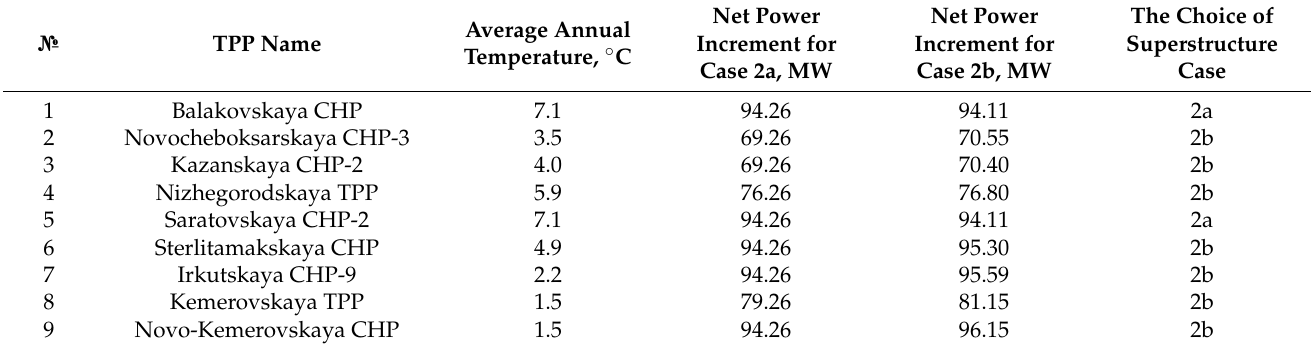
Table 8. The comparison of the energy effect for modifications of TPPs with BPSTs.